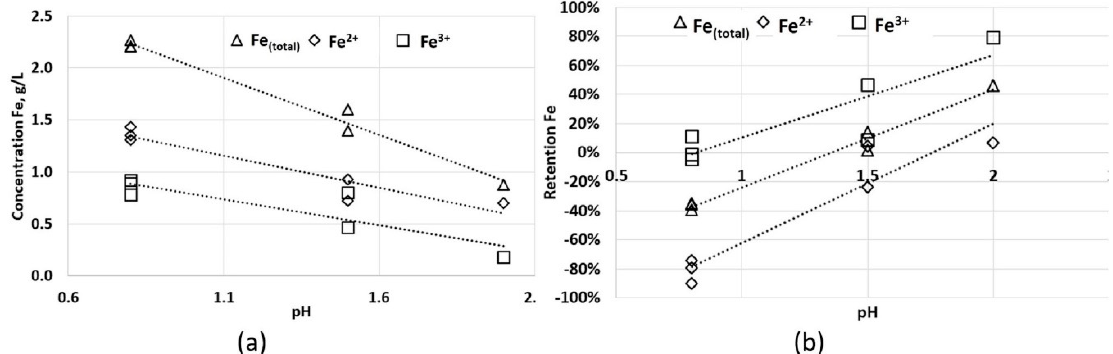
Figure 5. ( a ) Fe concentration in solution and ( b ) Fe retention in function of the pH (0.8 to 2) and Eh (510 to 540 mV).